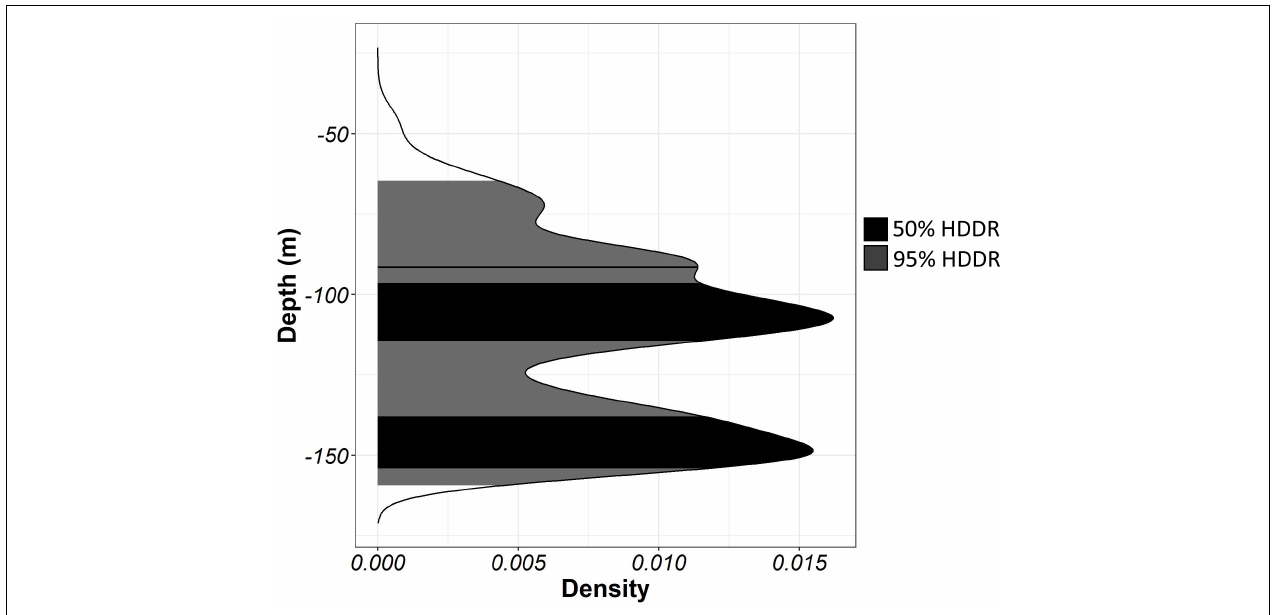
FIGURE 2 | An example monthly depth distribution with 50 and 95% highest density depth regions (HDDRs) identified using highest density intervals (HDIs).